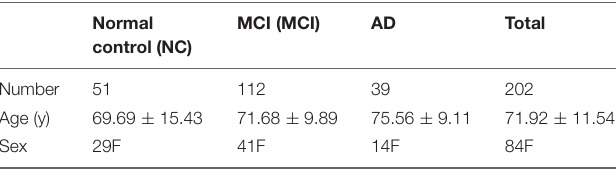
TABLE 1 | Summary of ADNI data used in this